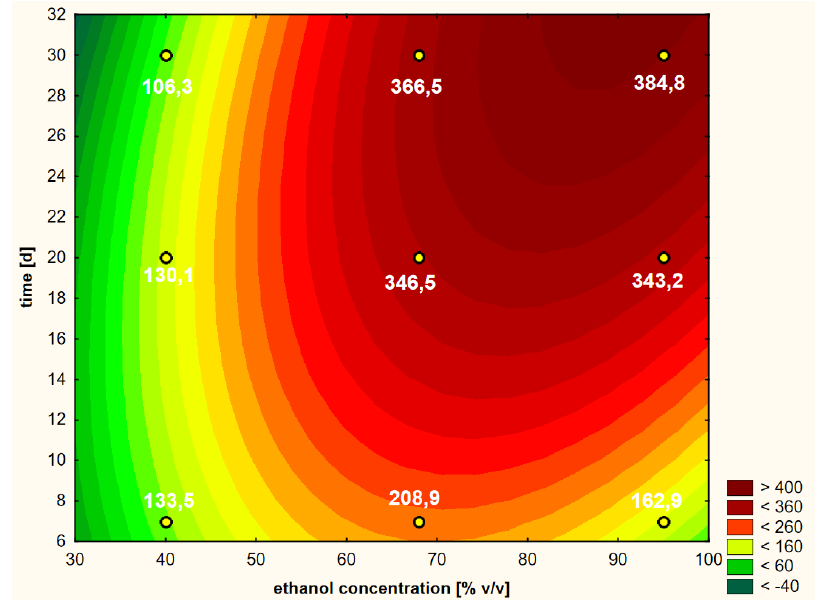
Figure 4. Model of the response surface (2D) regarding the contents of chlorogenic acid in ethanol extracts of elderberry flowers obtained from fresh raw material that was initially treated with warm ethanol at 50 °C.